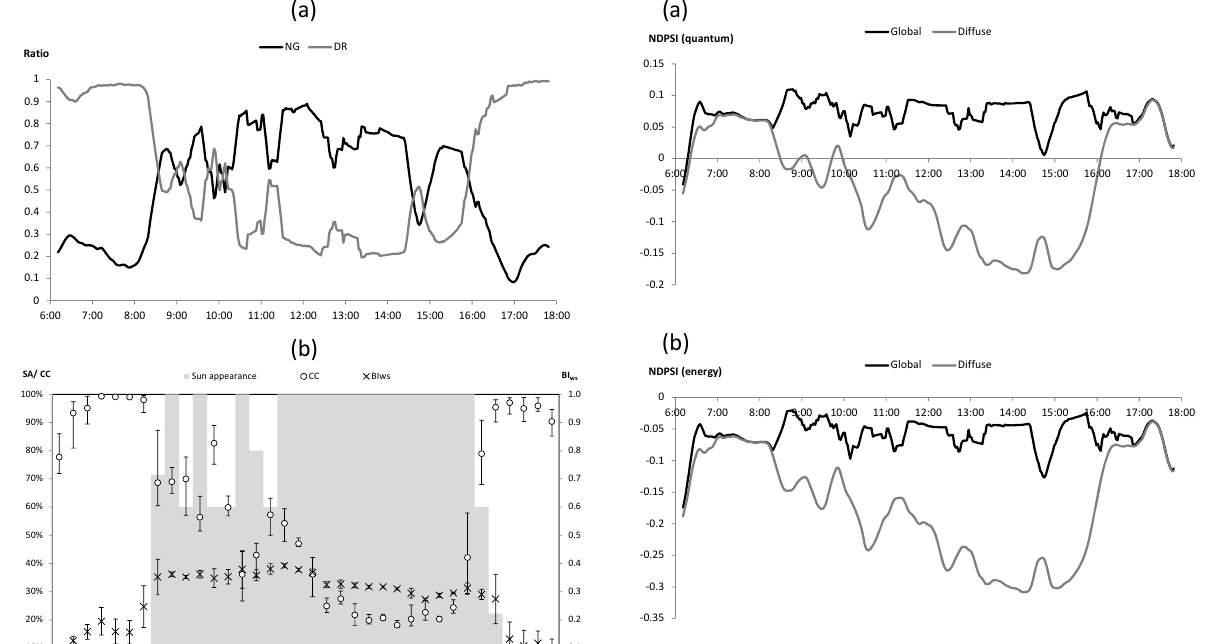
Fig. 3 Diurnal changes of (a) NDPSI with quantum units and (b) NDPSI with energy units at 20-minute average on 26 th Aug.